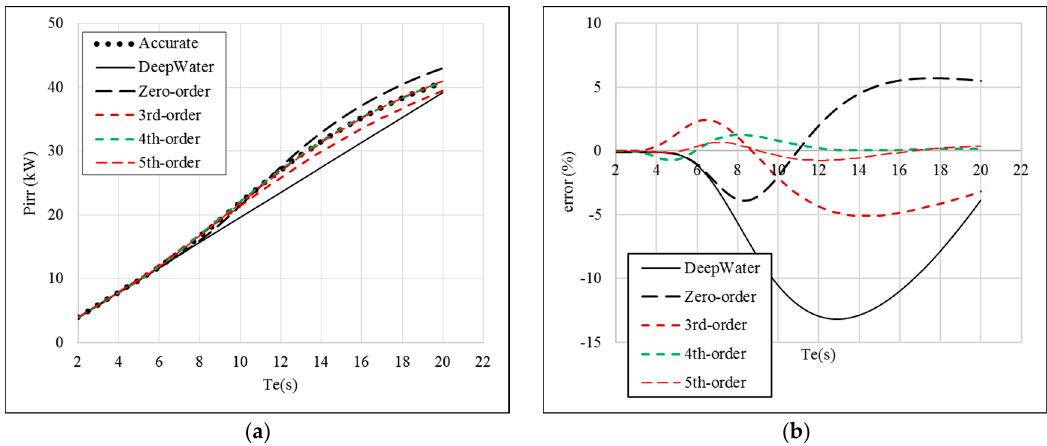
Figure 5. Comparison of the calculated wave power and the corresponding error using different methods for Bretschneider spectra of H m 0 = 2 m (water depth = 50 m). ( a ) Calculated wave power; ( b ) Error.